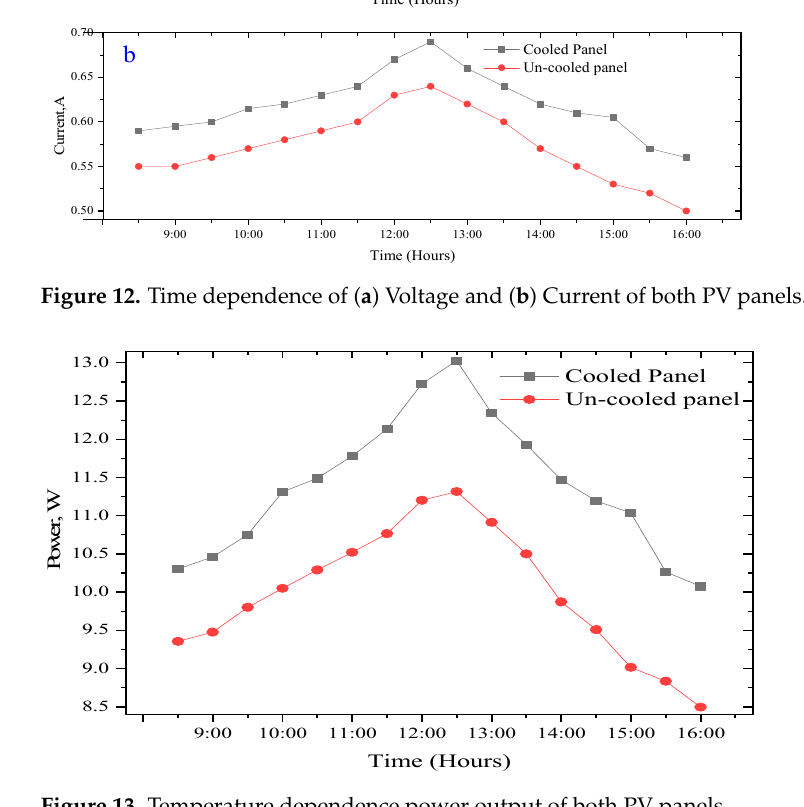
Figure 13. Temperature dependence power output of both PV